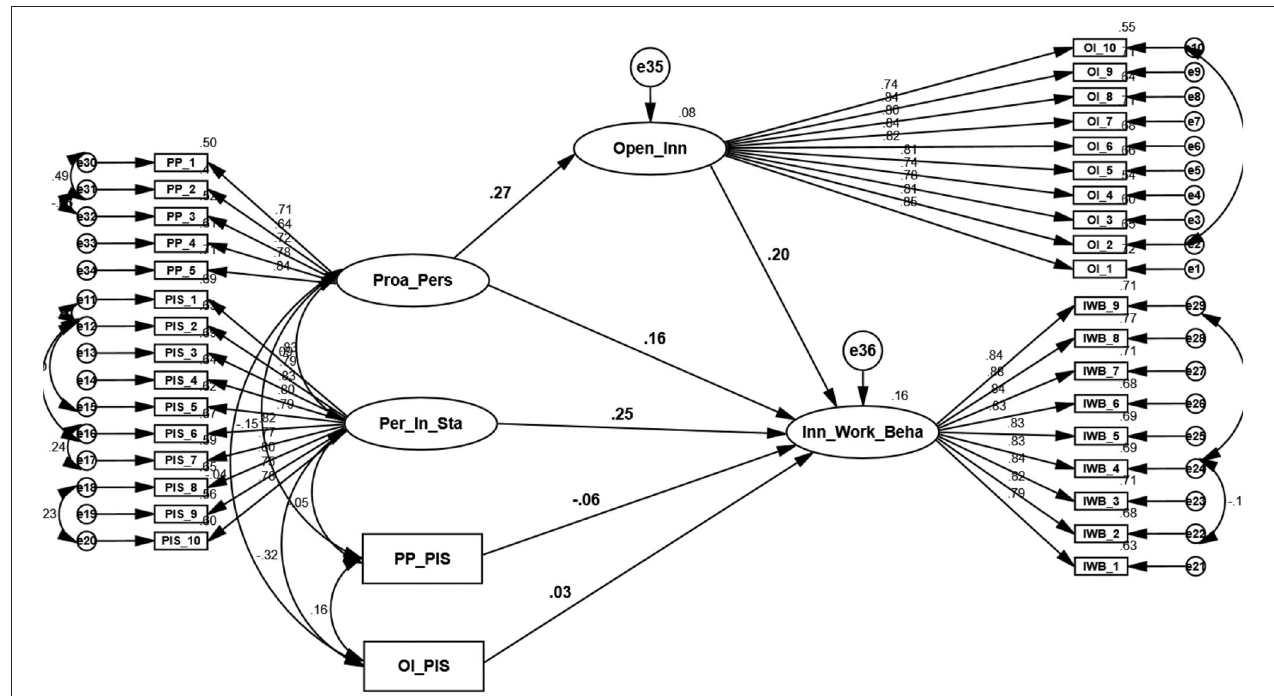
FIGURE 3 | SEM Model . Source: generated through AMOS.